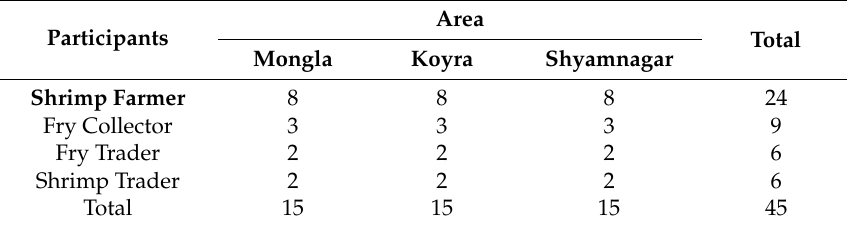
Table 1. Selection of